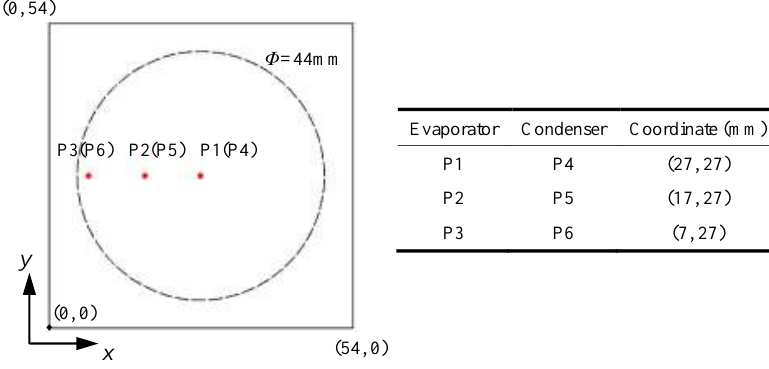
Figure 5. Position of measuring points on evaporator and condenser surface.